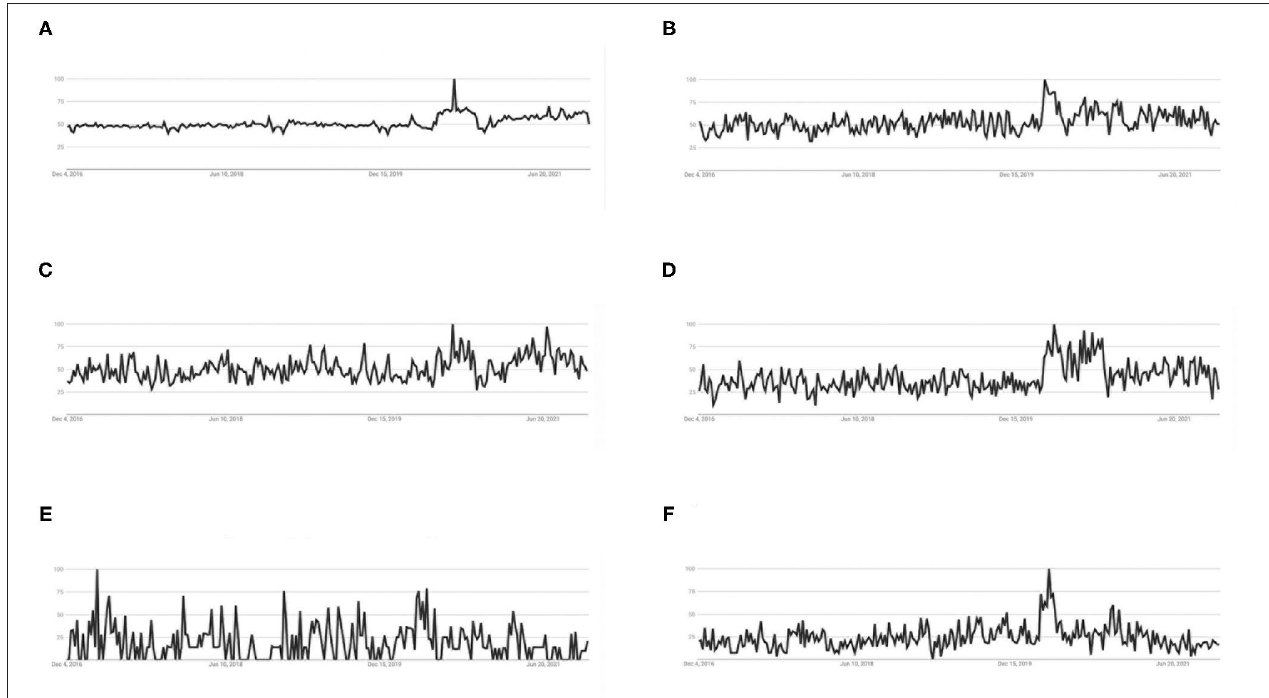
TABLE 1 | 2020 Results for local restaurant/food/farm tweets out of all local tweets ( n = 6,218) for states ranked low, middle, and high in local food system infrastructure (LFSI) a . State rankings States (UCS LFSI ranking)